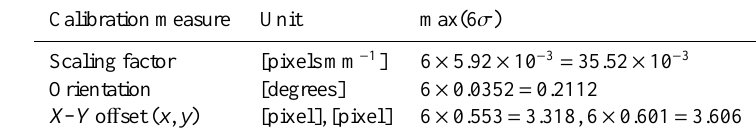
Table 1. Results of camera calibration.